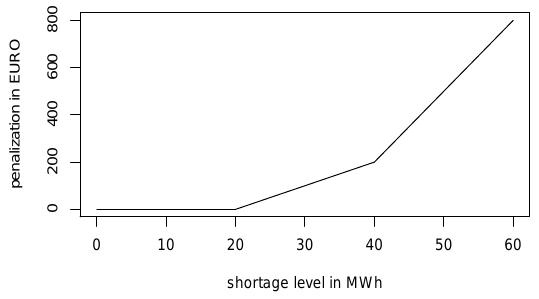
Figure 2. A function as in (43) for 60 MWh, penalizing the middle and upper range of shortage